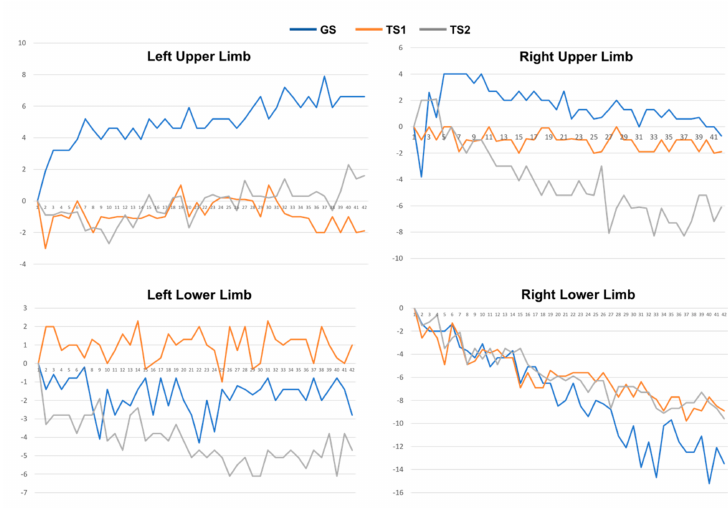
Figure 3. Drift trajectories of 4-limb movement of a patient measured in GS, TS1, and TS2.